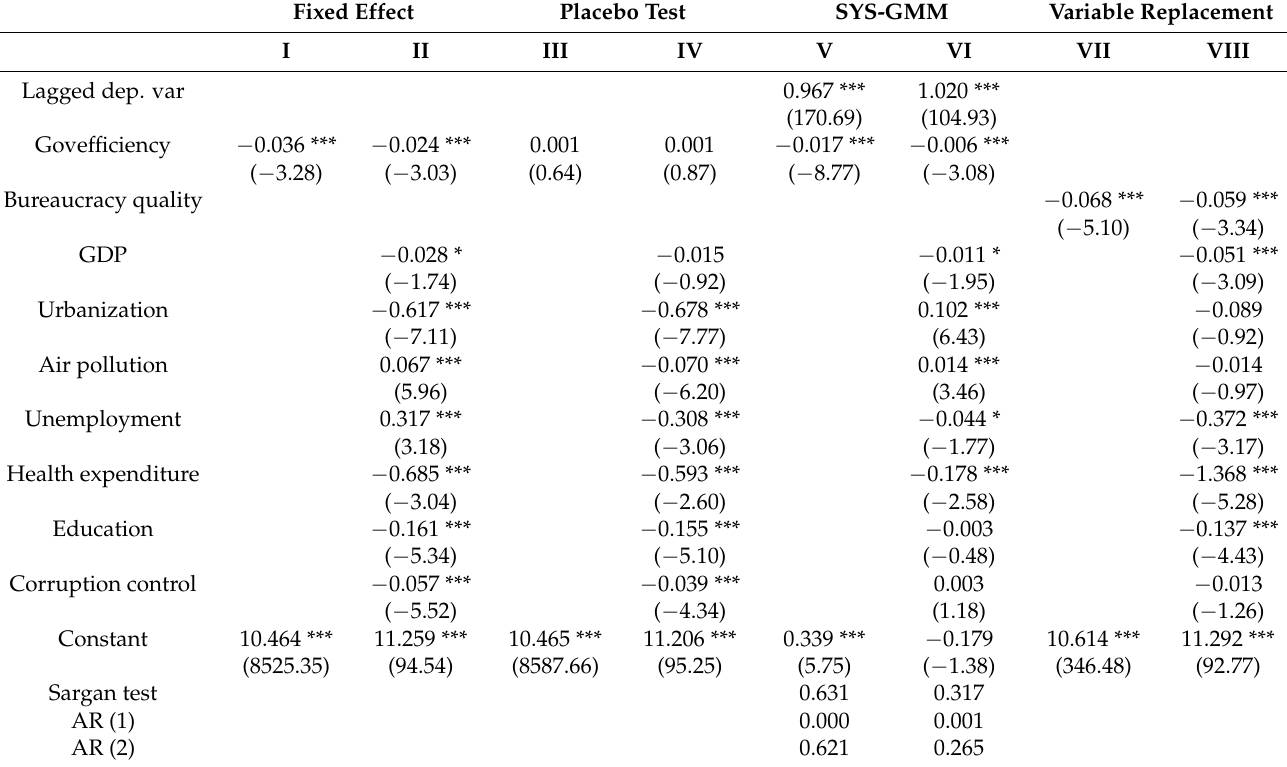
Table 3. Baseline regression results and robustness